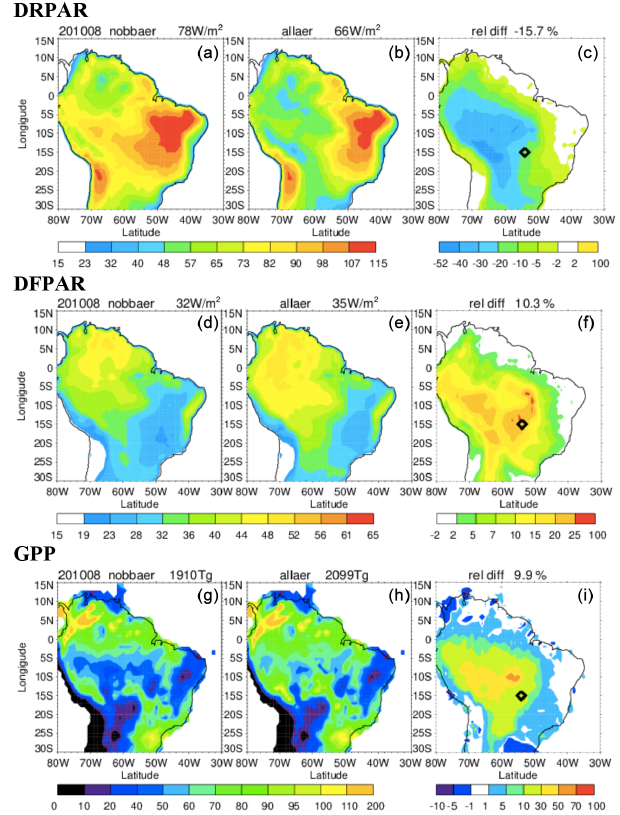
Figure 11. August 2010 Amazon DRPAR (Wm − 2 ) (a, b, c) , DF- PAR (Wm − 2 ) (d, e, f) , and GPP (kgm − 2 s − 1 ) (g, h, i) from the nobbaer (a, d, g) and allaer (b, e, h) GEOS experiments. The (c, f, i) show the relative change between allaer and nobbaer. All values are the Amazon regional average except the GPP values of (g, h) are regional total. Further analyses on the (c, f, i) diamond locations are given in Fig. 10.